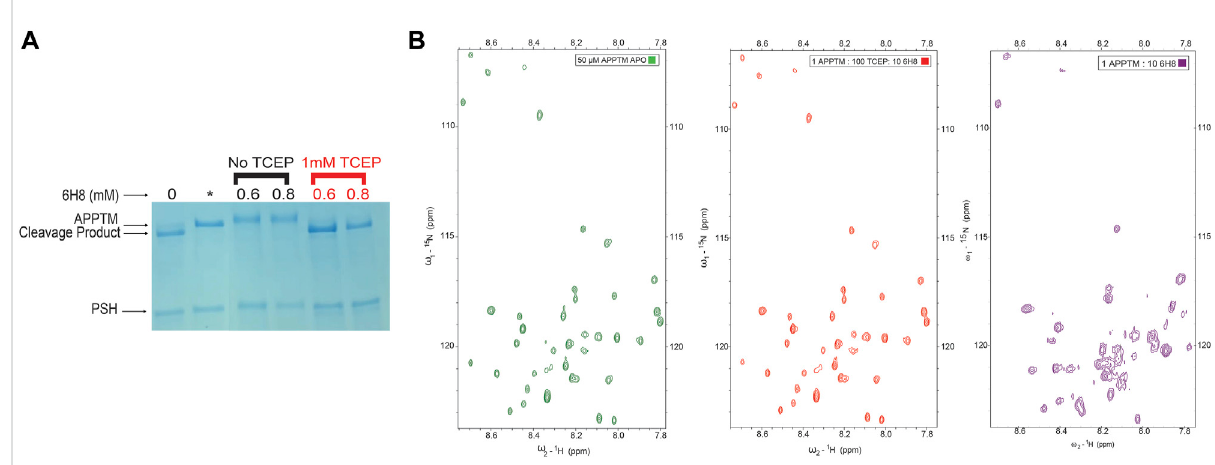
FIGURE 6 Ef fi cacy of 6H8 in inhibiting intramembrane proteolysis and binding to APPTM under reducing conditions (A) . To con fi rm that ef fi cacy of 6H8canbeeliminatedwithreducingagentanotherPSHgelassaywasrunwithexcess6H8.Withan excessof0.6and0.8 mM6H8withandwithout TCEP (black and red respectively) as the reducing agent 6H8 ’ s ef fi cacy is eliminated (B). Comparison of 2D 1H-15N TROSY spectrum of 50 μ M APPTM APO (green) and 1:100:10 APPTM: TCEP: 6H8 (red). Notably K53-K55 are unaffected by 6H8 in the presence of TCEP indicating that in thepresence of excess reducing agentsthe binding of 6H8 iseliminated. Final spectrum is 1:10 APPTM:6H8 (purple).Thereis asigni fi cant difference between this spectrum and its neighboring red spectra that has excess TCEP along with 6H8, indicating elimination of reactivity of 6H8 under